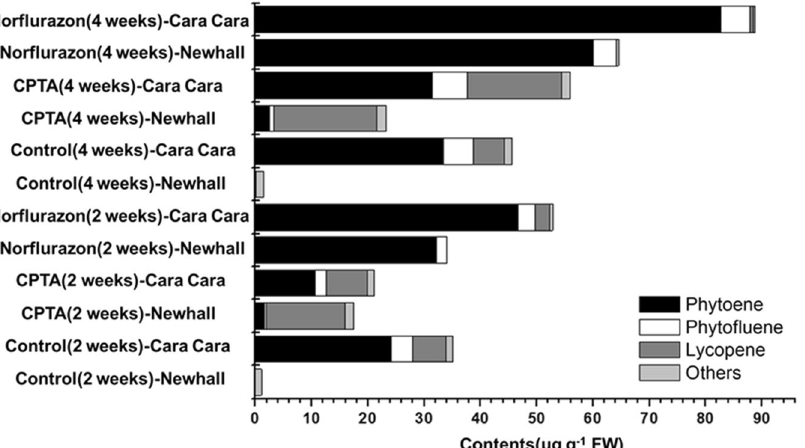
Figure 10. Amount and composition of carotenoids in in vitro cultured flesh tissues of Newhall and Cara Cara following CPTA and norflurazon treatments. The 0 week tissues were separated from fruit at the S5 stage. CPTA,